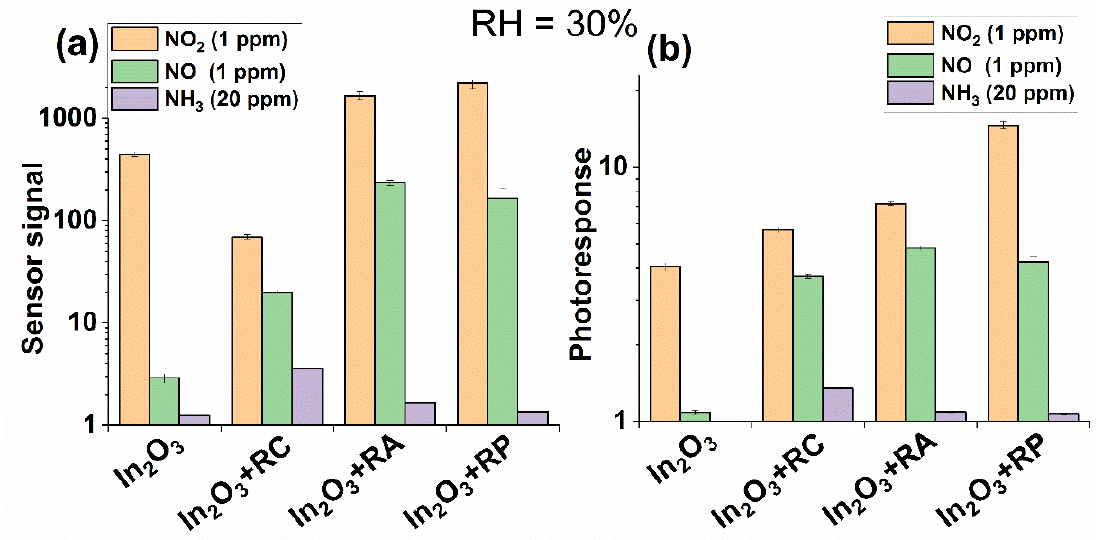
Figure 8. Comparison of the sensor signal ( a ) and photoresponse ( b ) of the samples towards different concentrations of NO 2 , NO, and NH 3 at room temperature with RH = 30%.